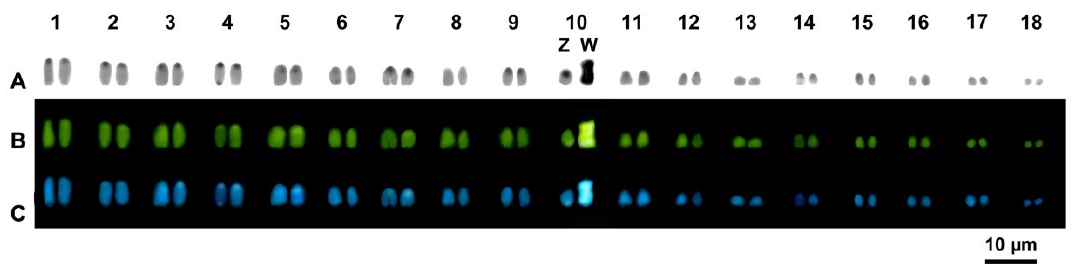
Figure 2. Metaphase plates of U. ebenaui ( A , D , G ), U. finiavana ( B , E , H ) and U. pietschmanni ( C , F , I ) sequentially stained with C-banding + Giemsa ( A – D ) + CMA 3 ( D – F ) + DAPI ( G – I ).